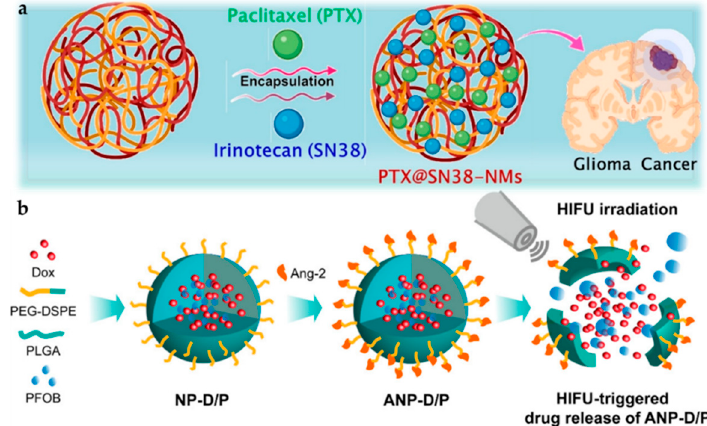
Figure 8. Scheme of various nanoparticle systems with embedded drugs. ( a ) Graphical representa- tion of PTX and SN38 encapsulated inside PCECs [125]. ( b ) Illustrative model of synthesis and HIFU-triggered drug release from ANP-D/P [134]. Adapted with permission from Refs. [125,134]. Copyright 2021 Elsevier and 2017 American Chemical Society.